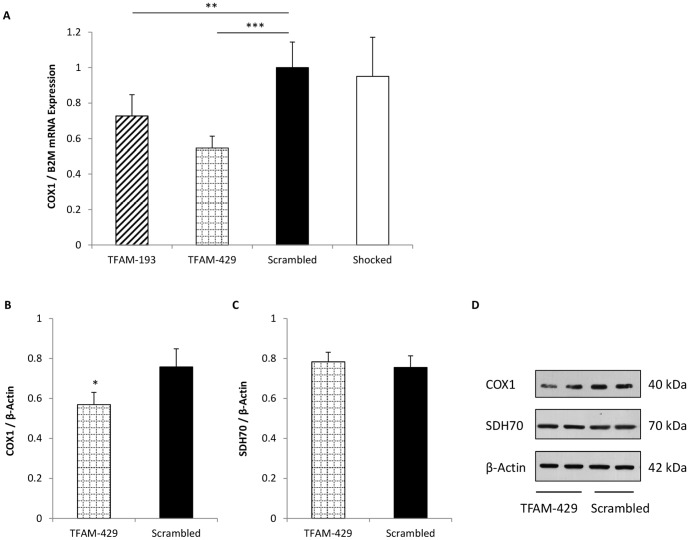
The effect of partial mtDNA depletion on mitochondrial gene transcription and protein translation.Mitochondrial DNA was depleted following TFAM silencing and COX1 mRNA expression was quantified relative to reference gene B2M 72 h post transfection (A). Protein was extracted 72 h post transfection and analysed by western blotting, probing for COX1, SDH70, and β-Actin proteins. Protein bands were quantified by densitometry, and optical density readings used to calculate the ratio of COX1 (B) and SDH70 (C) mitochondrial proteins relative to β-Actin loading control. A representative blot is shown in (D). Data in (A) are normalised to Scrambled control cells. Both experiments repeated 3 times, with each experimental repeat performed in triplicate (A) or duplicate (B, C). Data presented are means ± SEM. * p<0.05, ** p<0.01, *** p<0.001. COX1, Cytochrome c Oxidase 1; SDH70, Succinate Dehydrogenase 70 kDa subunit.